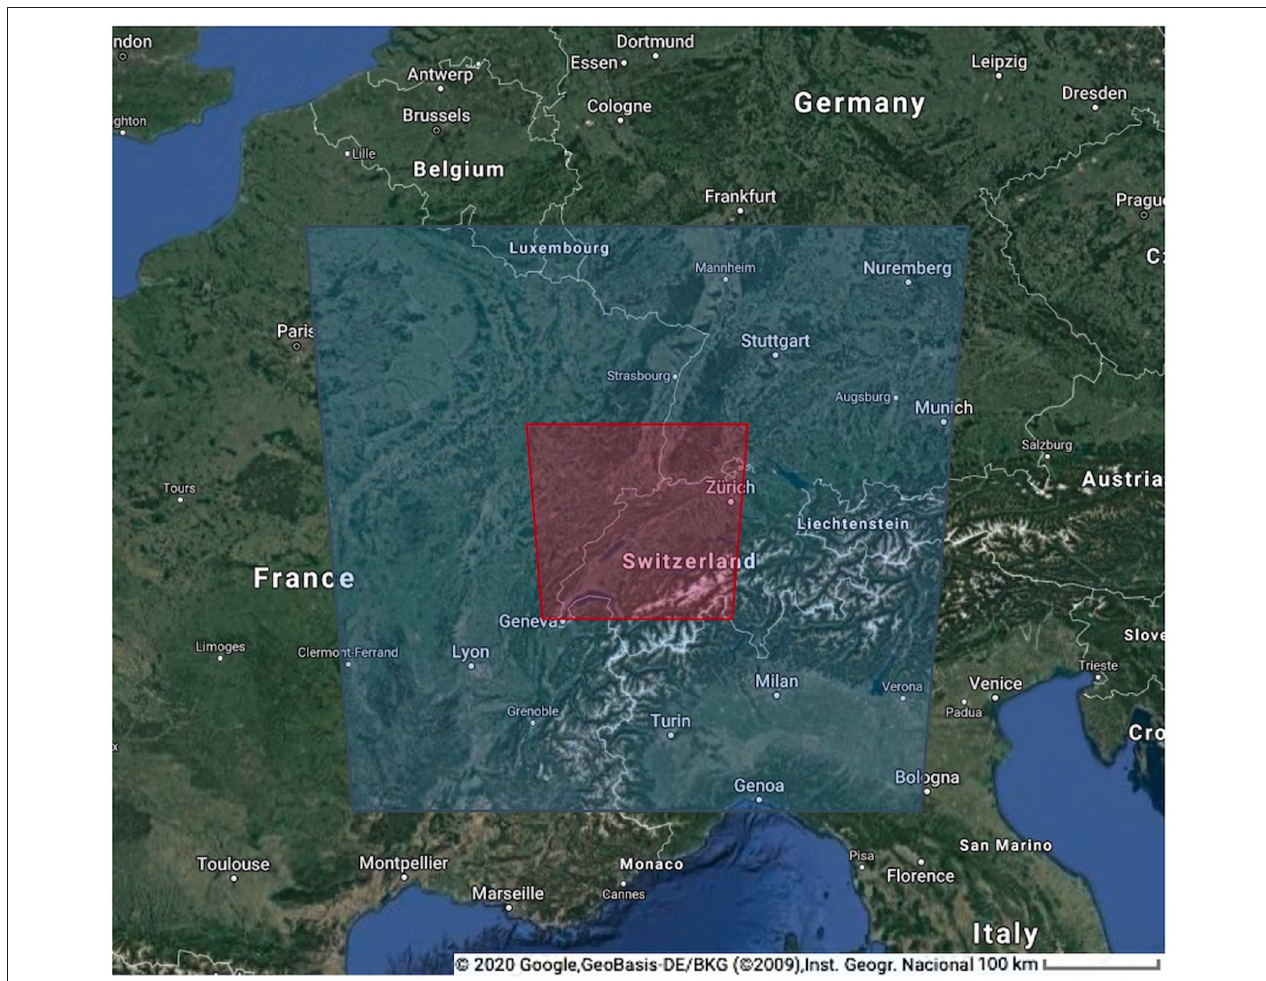
FIGURE 1 | The analysis region over central Europe used in this study indicated with red box (temperature) and blue box